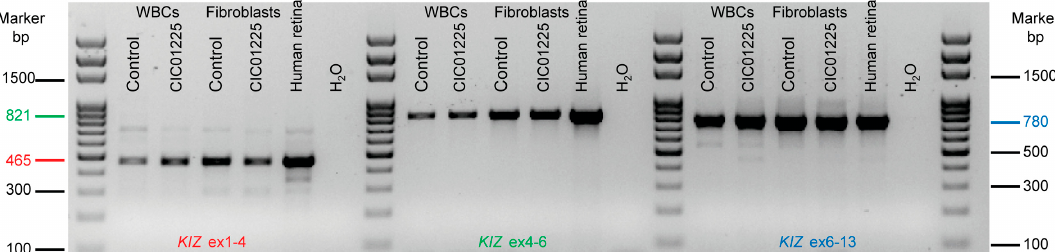
Figure 3. Presence of KIZ transcript 1 (NM 018474.4) in WBCs (whole blood cells), human fibroblasts of CIC01225 and in non-mutated control and human retina. PCR on cDNA revealed in all tested tissues exons 1–4 (red), exons 4–6 (green) and exons 6–13 (blue) transcripts with the expected size of 465, 821 and 780 bps, respectively. Sanger sequencing confirmed the correct sequences of the respective fragments and showed in addition the presence of the mutations in the cDNA made from WBSs and fibroblasts from the patient CIC01225.